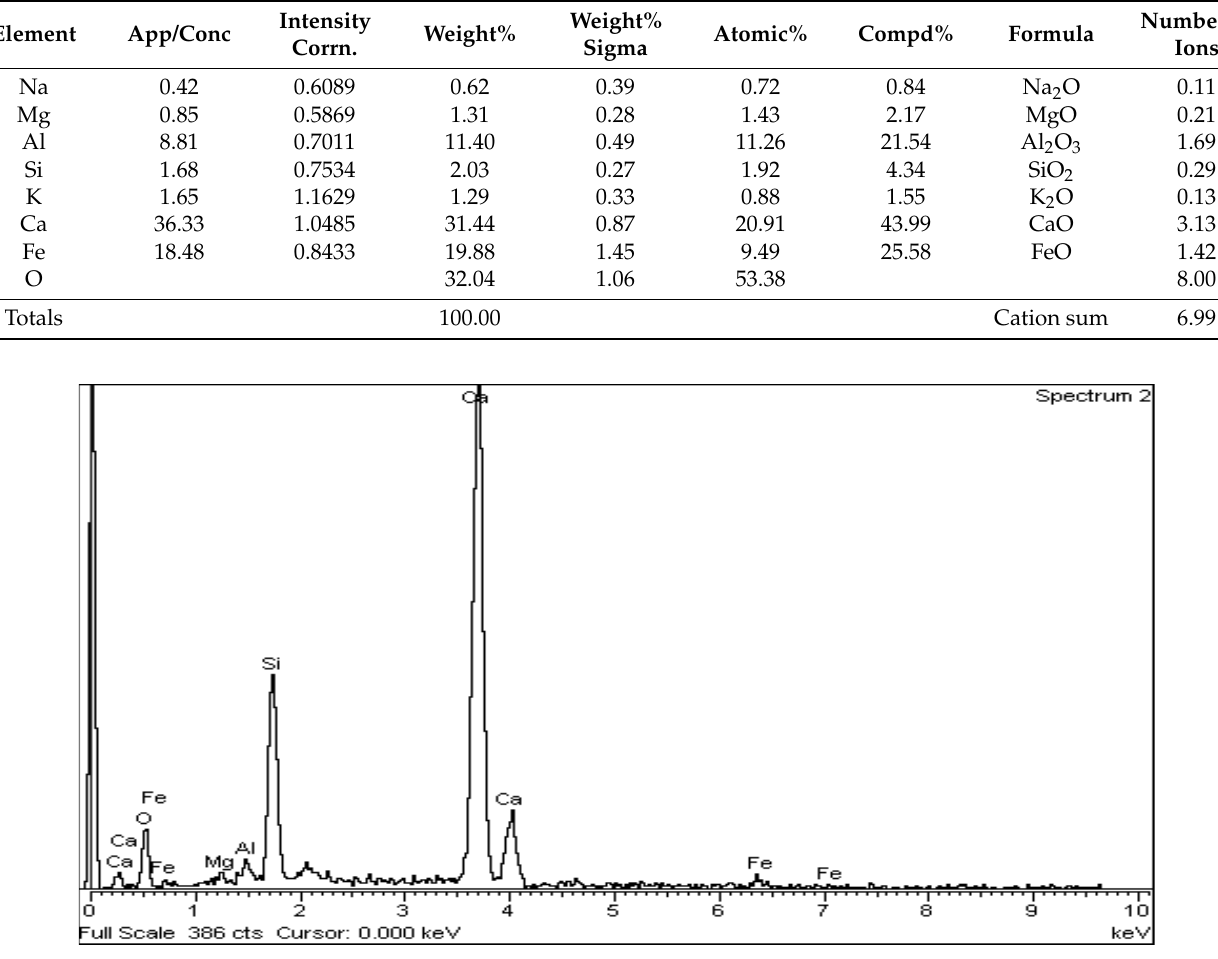
Figure 17. EDS analysis for alite crystal of point “ Spectrum 2 ” of Figure 15.